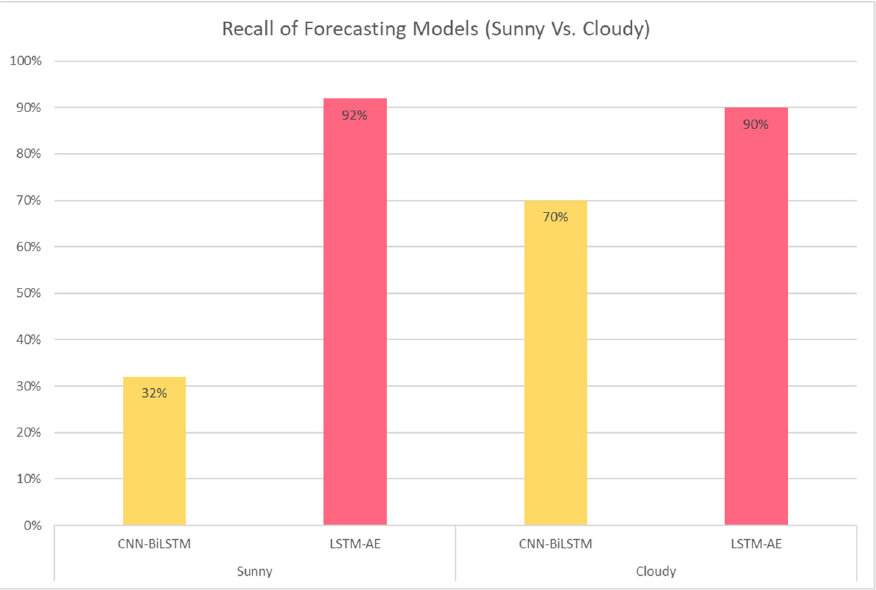
Figure 36. Recall of the two forecasting models (sunny vs. cloudy) in model prediction engine.